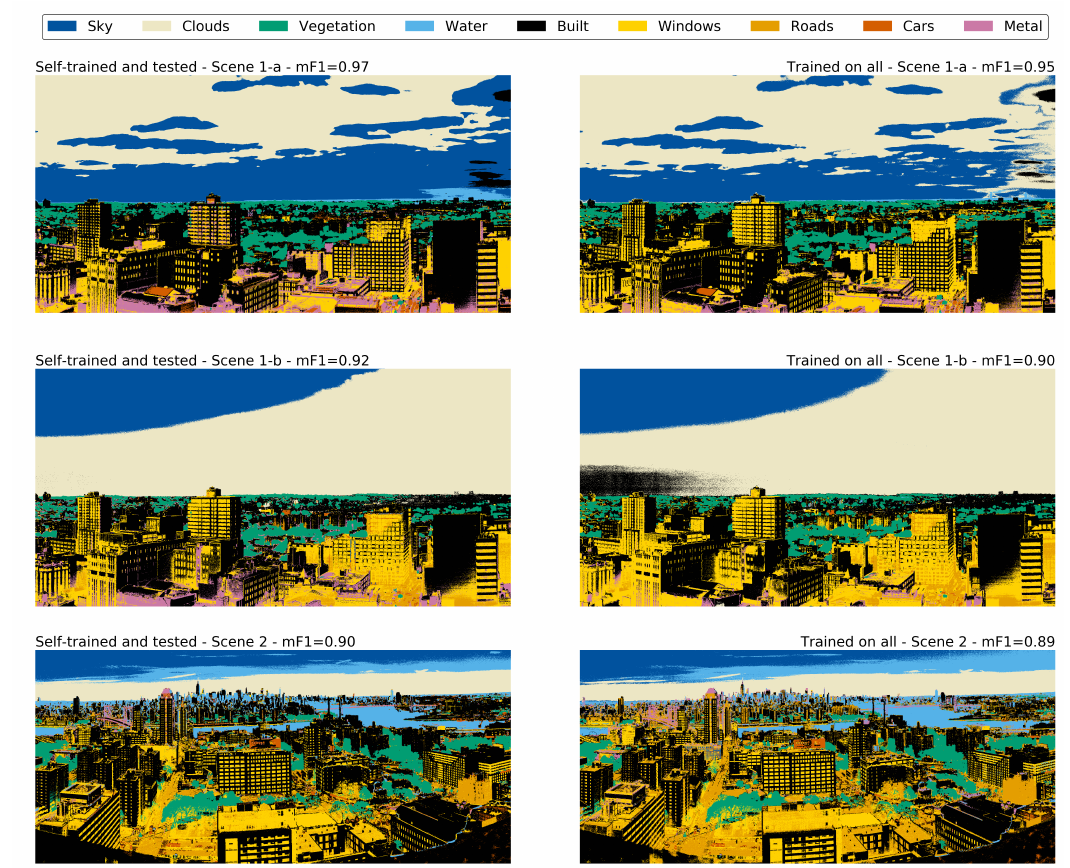
Figure 8. Image segmentation result from Model 2 trained and tested on Scene 1-a ( top left ), Scene 1-b ( middle left ), and Scene 2 ( bottom left ), compared to training Model 2 on all scenes at once, and testing on each individually ( right ). The model architectures and hyperparameters are shown in Figure